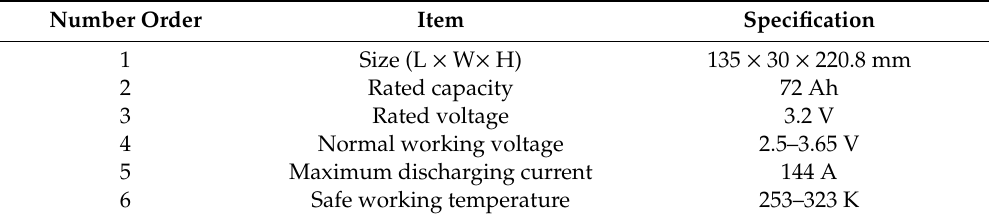
Table 1. The parameters of the CALB-L135F73 LiFePO 4